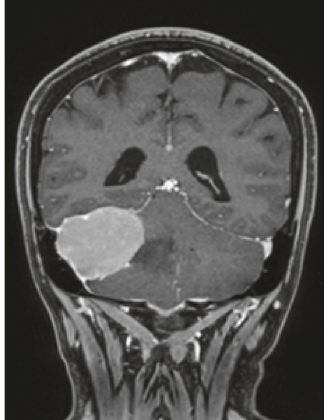
Figure 2: Coronal view of contrast-enhanced MRI scan showing a well-defined tumor with a clear margin. Compression by the mass toward the fourth ventricle caused